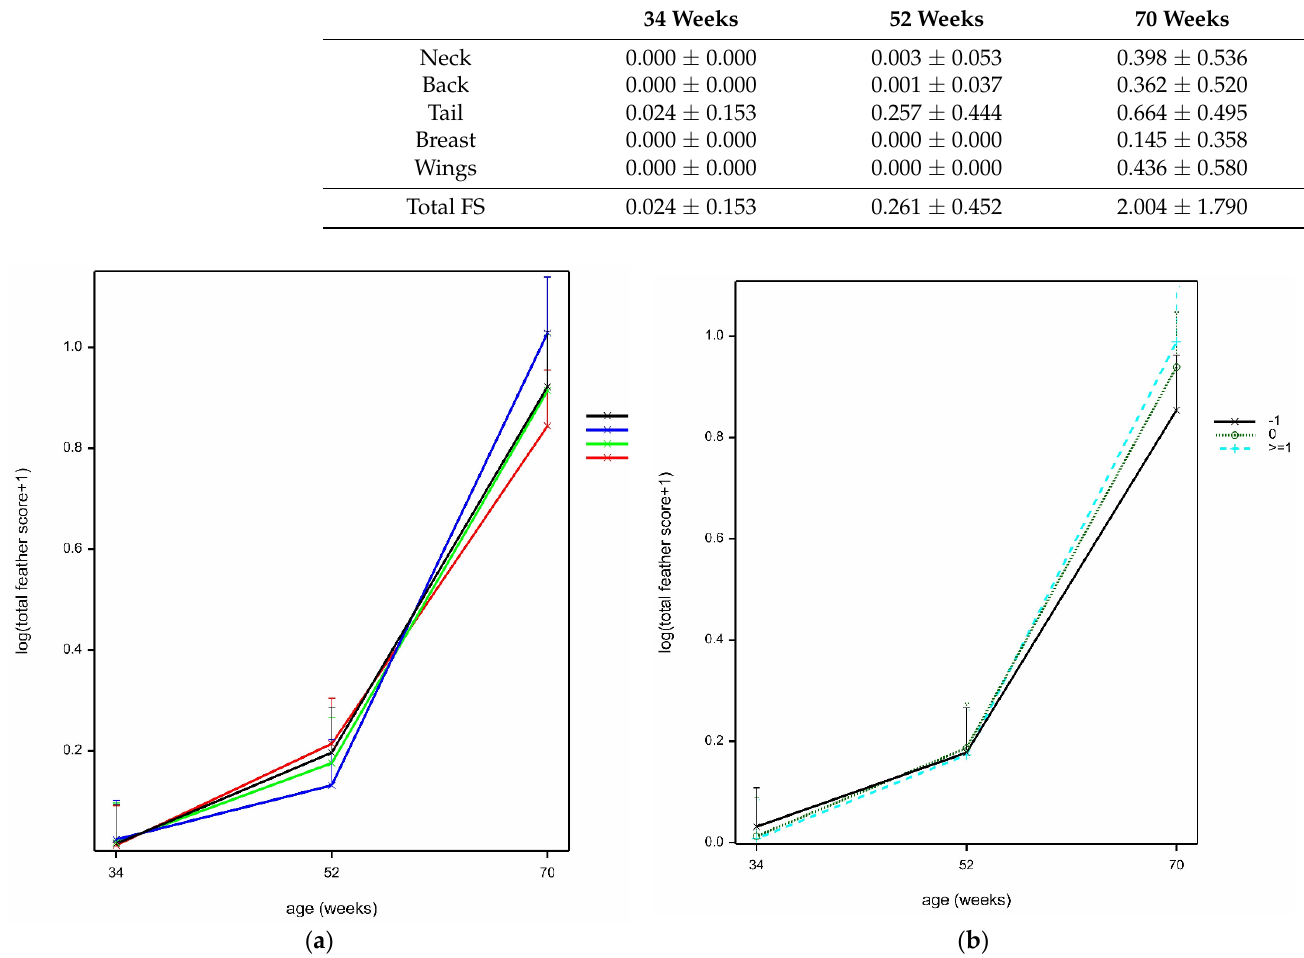
Figure 9. ( a ) Mean ± SE log (total feather score + 1) by age (34, 52, 70) and treatment (R, B, PB, PF), estimated from LMM. ( b ) Mean ± SE log (total feather score) by age (34, 52, 70) and time relative to sca tt er ( − 0, 0, ≥ 1), estimated from LMM.